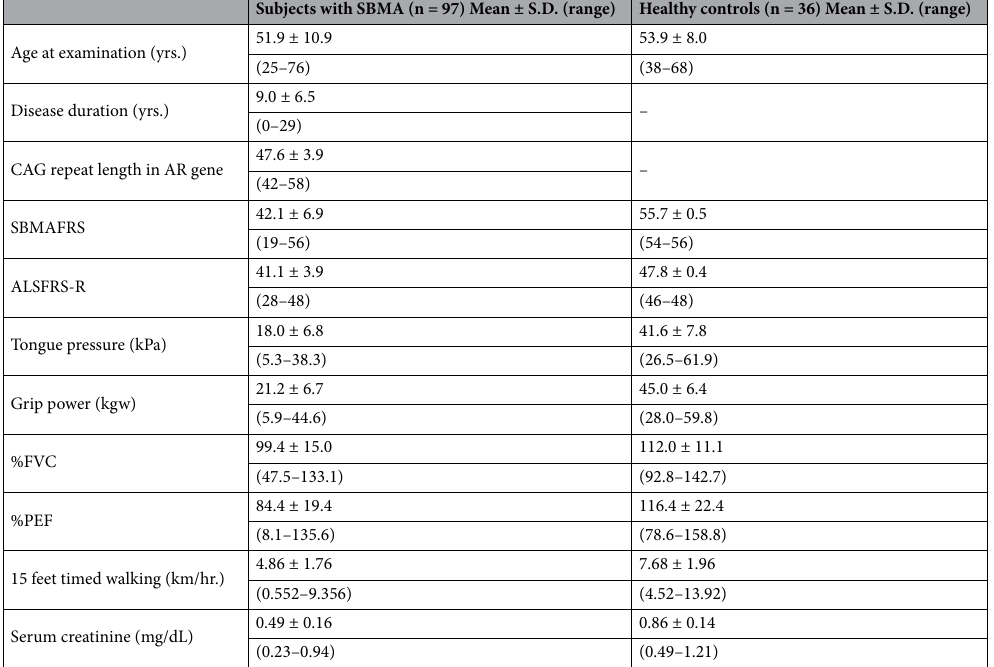
Table 1. Baseline characteristics. AR, androgen receptor; SBMAFRS, spinal and bulbar muscular atrophy functional rating scale; ALSFRS-R, the revised amyotrophic lateral sclerosis functional rating scale; %FVC, % forced vital capacity; %PEF, % peak flow; SD, standard